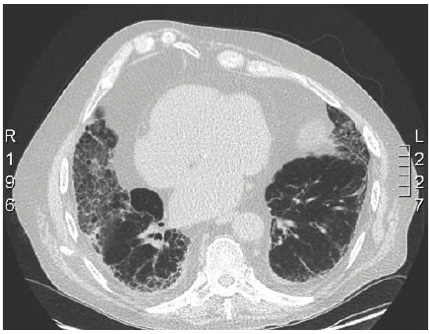
Figure 3: CT scan (prior to treatment) showing diffuse pulmonary fibrosis (honeycombing) and bilateral pleural fluid